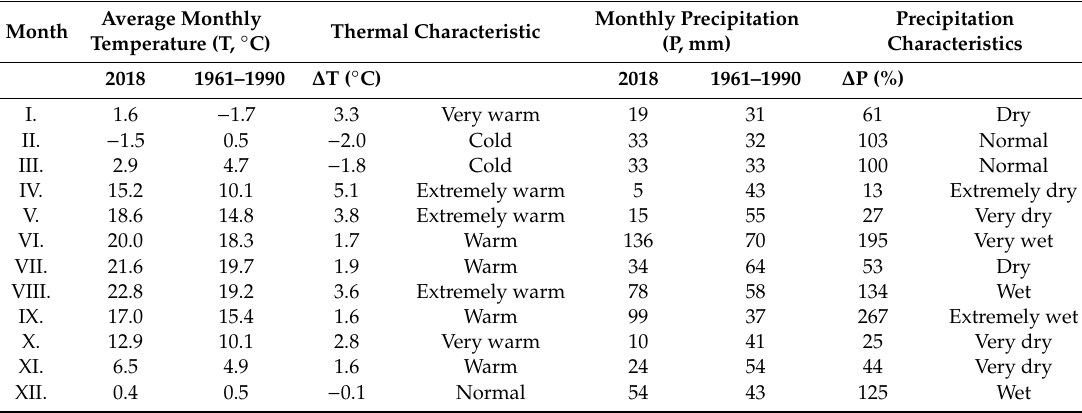
Table 4. The comparison of monthly precipitation totals and the average monthly temperature in 2018 with the climatological normal (period 1961–1990) for the locality of B á b (southwestern Slovakia). Average Monthly Monthly Precipitation Month Thermal Characteristic Temperature (T, ◦ C) (P,